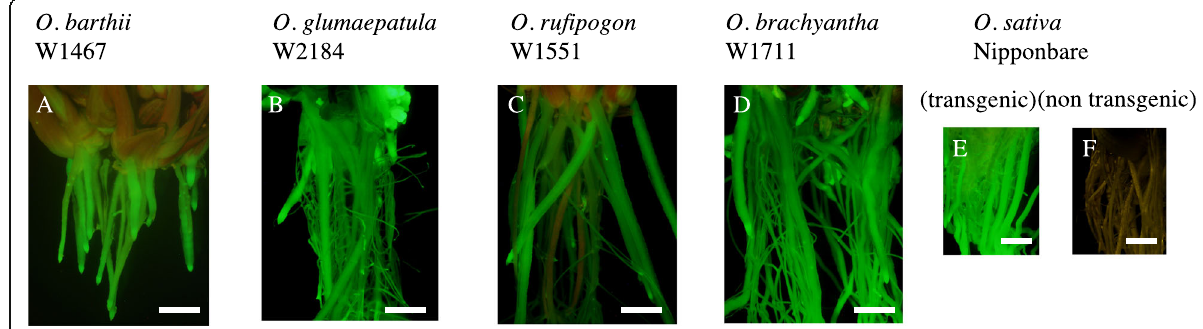
Fig. 2 Agrobacterium- mediated transformation of wild Oryza . a – e ) GFP fluorescence in roots of transgenic wild rice: a O. barthii W1467, b O. glumaepatula W2184, c O. rufipogon W1551, d O. brachyantha W1711, and e O. sativa Nipponbare. f Roots in non-transgenic Nipponbare as a negative control. Bar = 2